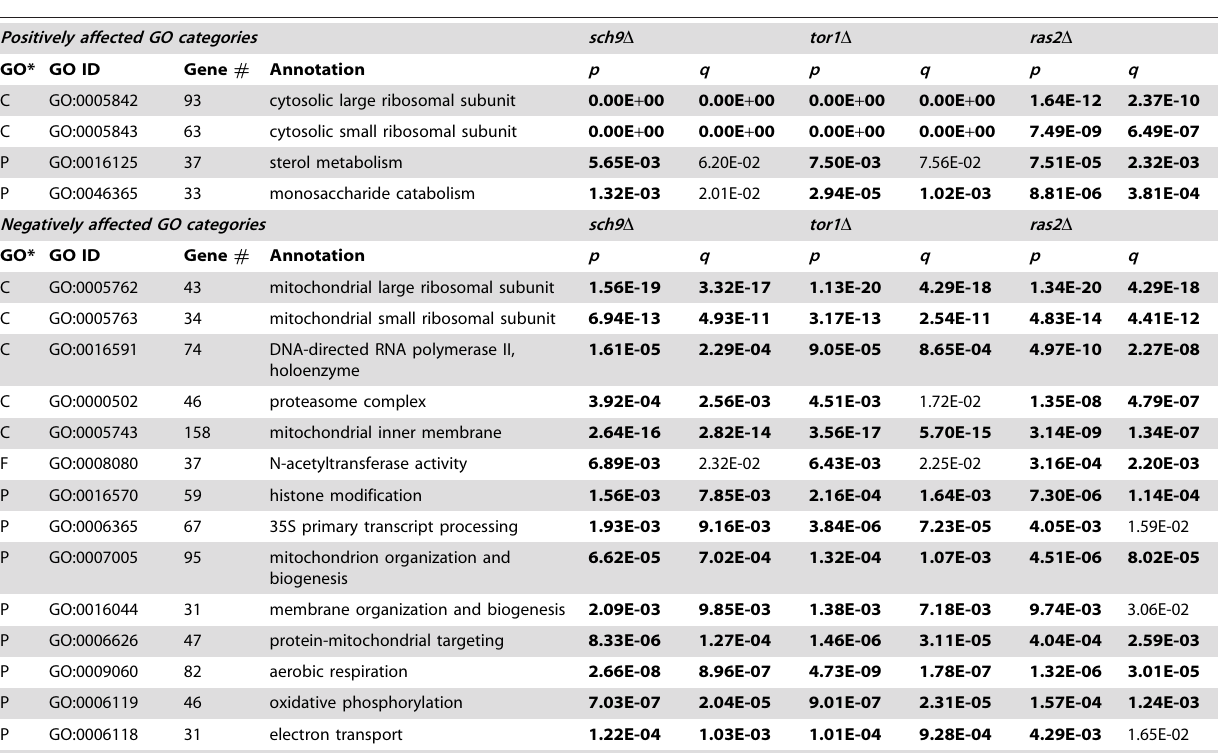
Table 1. Gene ontology (GO) analysis of expression profiles of long-lived